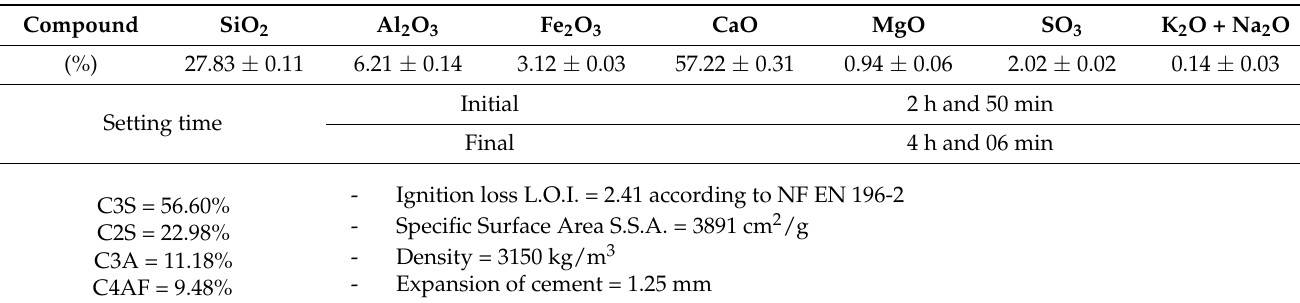
Table 2. Physico-chemical properties of the used cement.